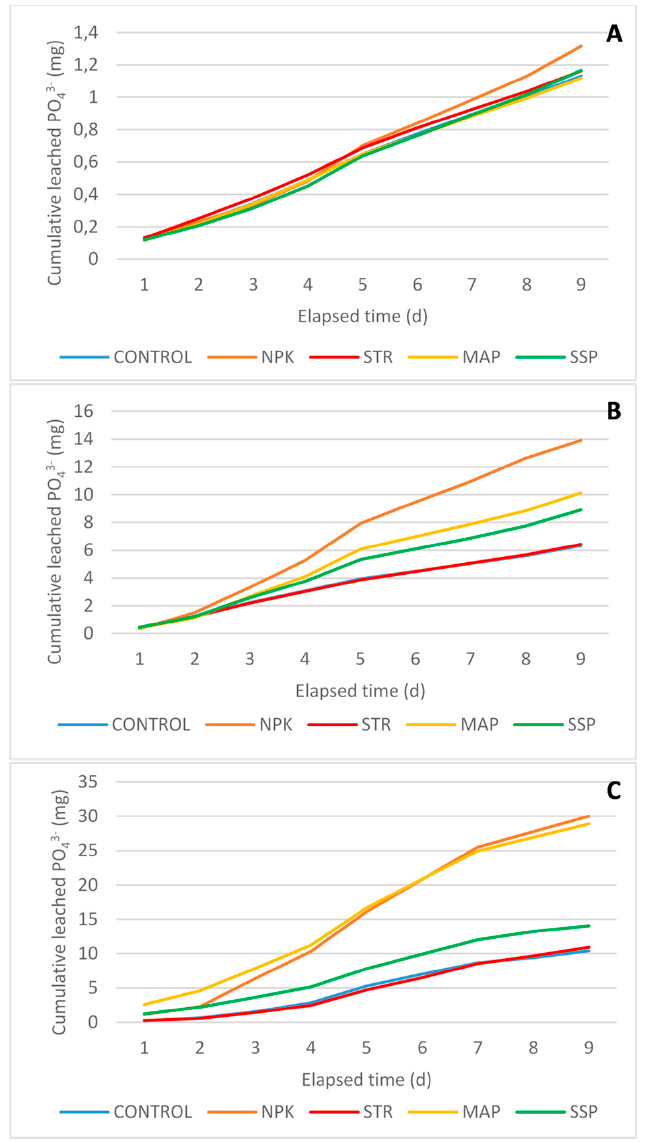
Figure 2. Amount of P salts leached from alkaline ( A ), neutral ( B ), and acidic ( C ) soil columns as a function of time in struvite and P fertilizers. Table 3. P losses (%) in the different soils for each fertilizer. Alkaline